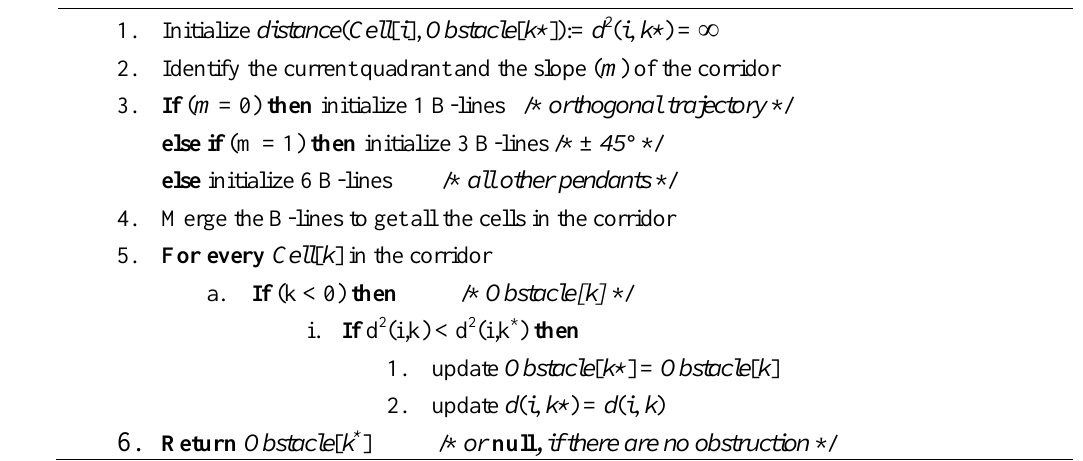
Code 1. Obstacle detection